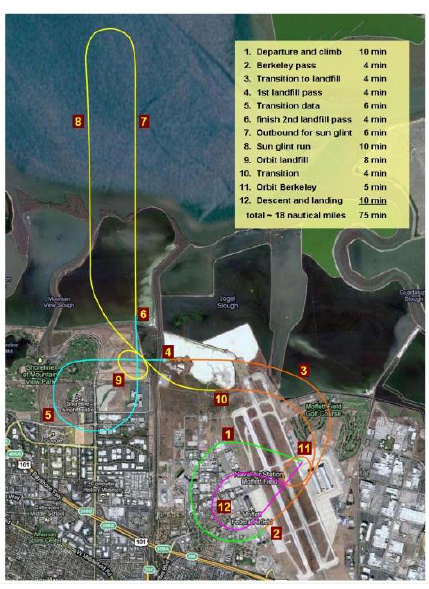
Figure 2. The Route of the Airship with TIMS